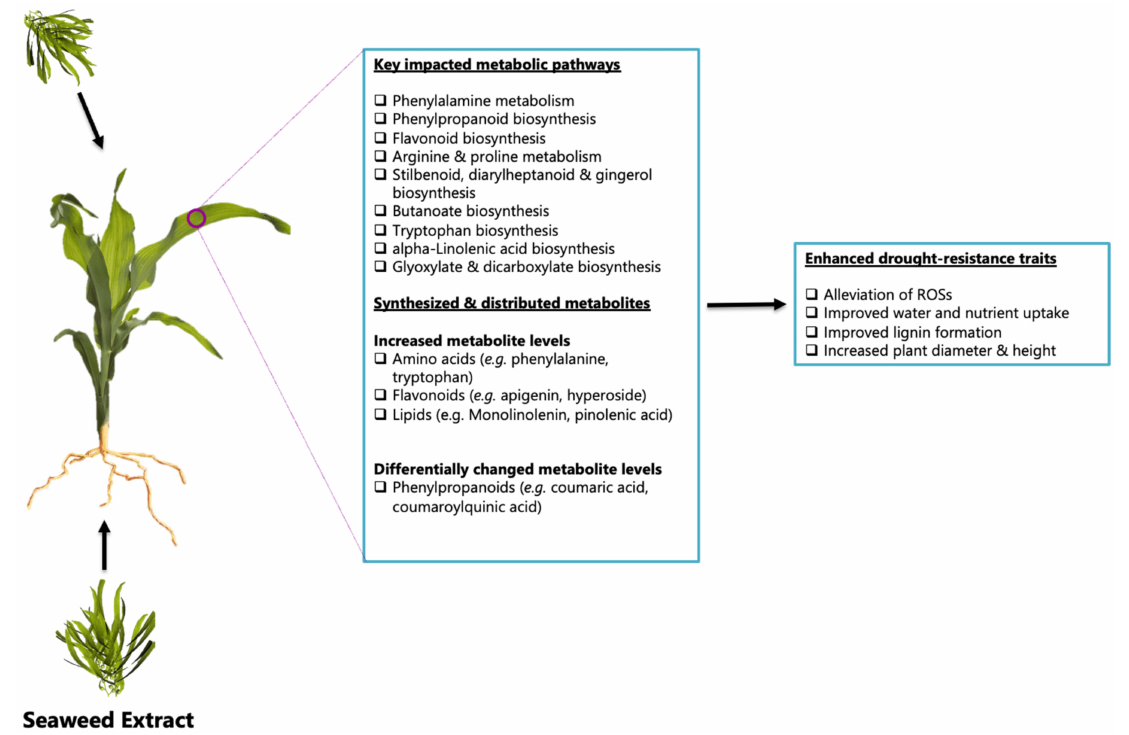
Figure 9. A summary of the results obtained in this study highlighting the general seaweed-based biostimulant’s mechanism of action. The metabolic and biochemical events observed in the seaweed- based biostimulant treated maize plants via soil and foliar application, displayed alterations in the primary and specialized metabolic pathways that resulted in increased synthesis and distribution of metabolites related to enhanced drought resistance